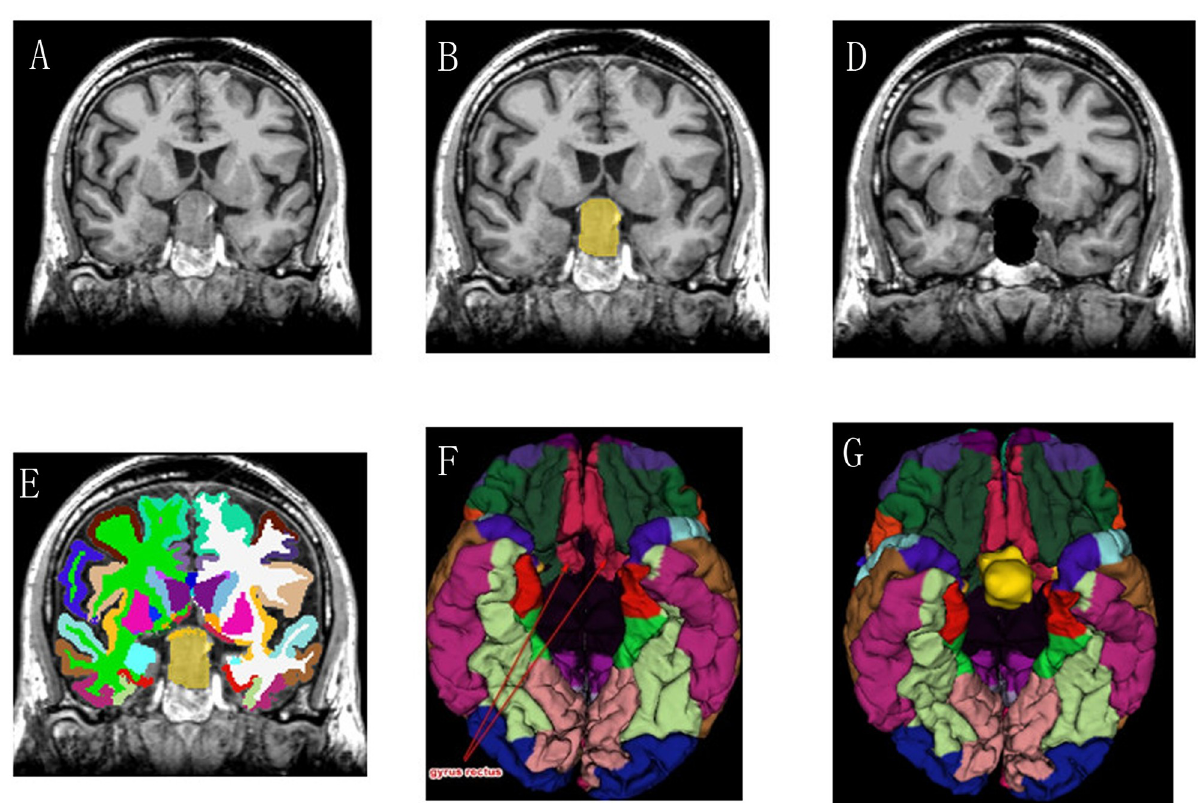
Fig 2. (Sub 6, Pituitary adenoma). These screenshots present the segmentation results in a coronal (A-C) slice for the automatic GrowCut tumor segmentation algorithm in 3D Slicer and automatic brain segmentation in FreeSurfer. The bilateral gyrus rectus was pushed and deformed by the tumor